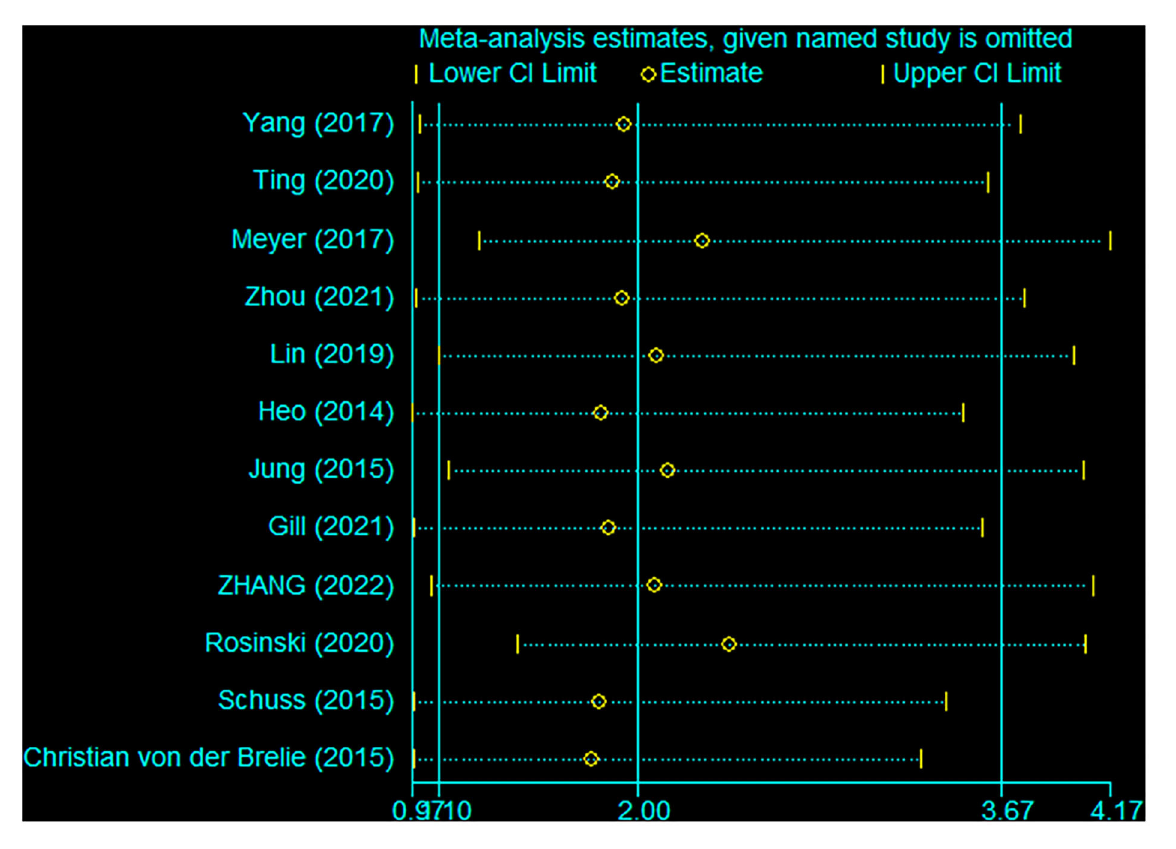
FIGURE3 Sensitivity analysis of overall complications after staged and concurrent cranioplasty and ventriculoperitoneal